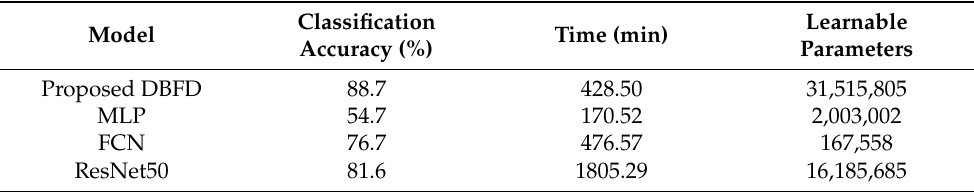
Table 9. Summary of performance metrics for the proposed model and SOTA models.